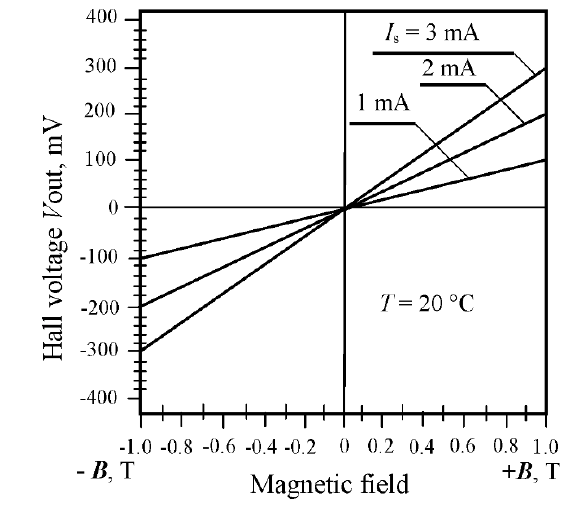
Figure 3. Output characteristics V out ( B